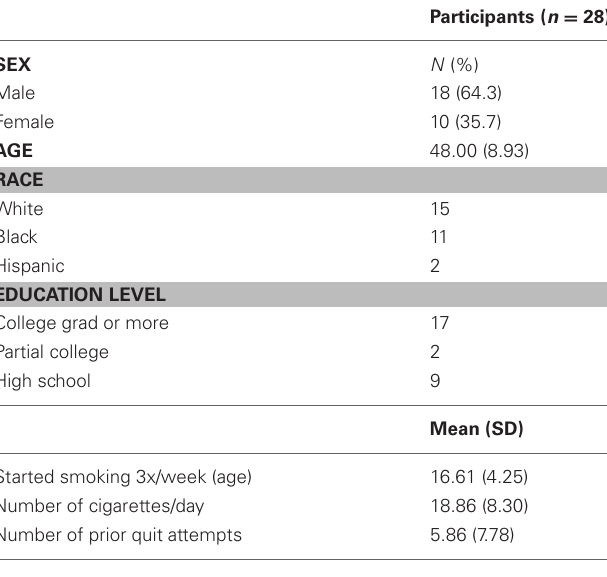
Table 1 | Pre-treatment characteristics of participants.